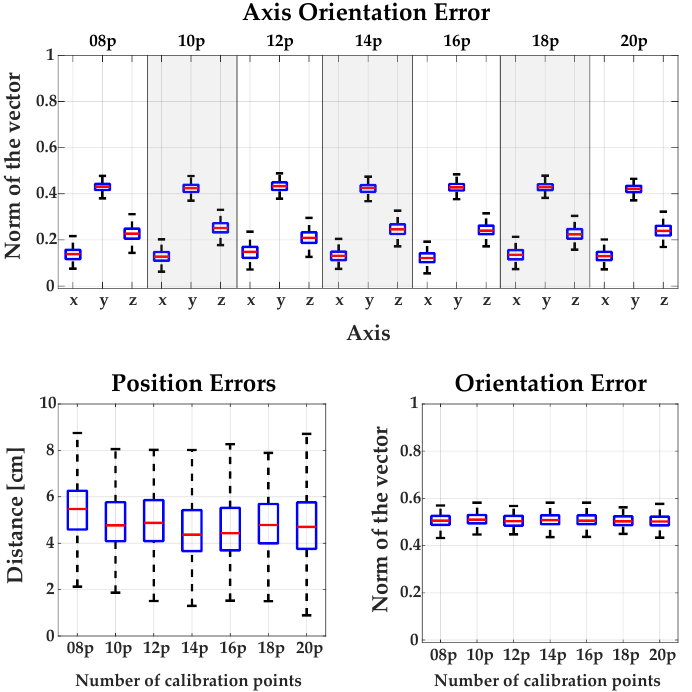
Figure A4. Results obtained by the XS calibration method using different numbers of calibration points.